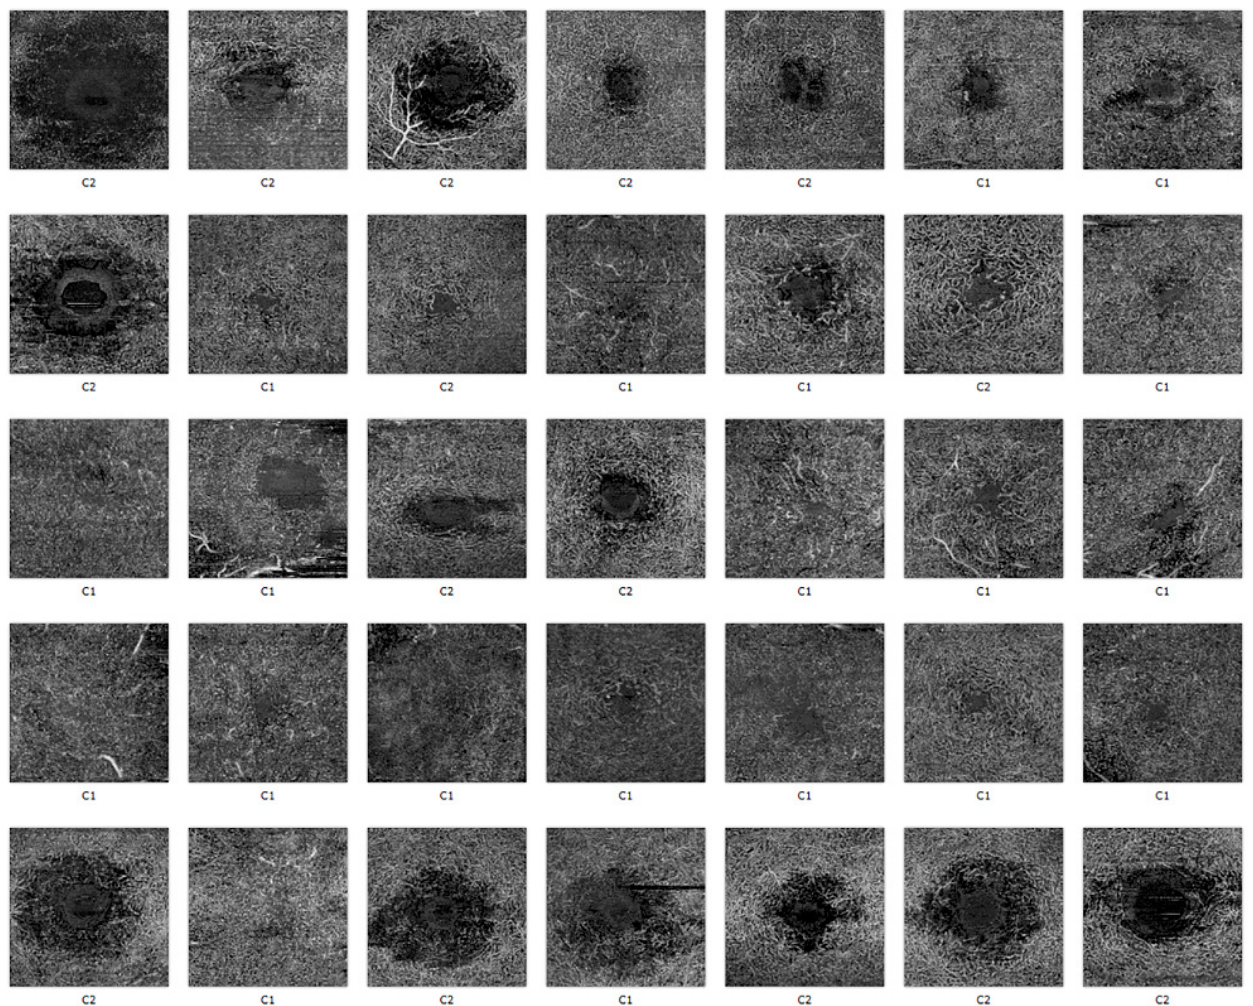
Figure 7. Deep vascular plexus of OCT-A images, as assigned to cluster 1 or 2 by the clustering algorithm based on the Inception V3 feature extraction.